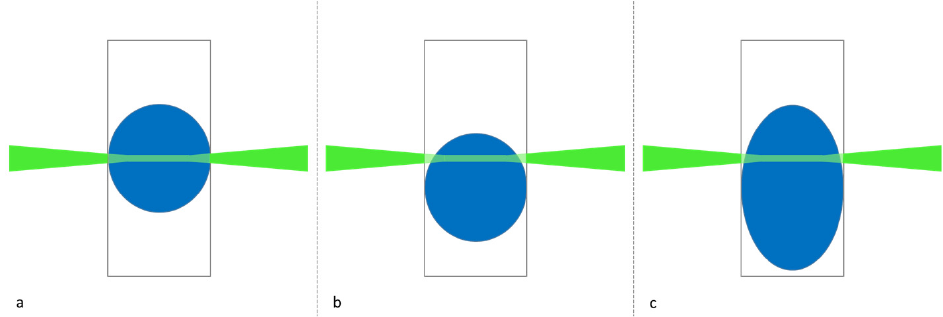
Figure 10. Effect of the positioning of the droplet in the laser. ( a ): The droplet is positioned centrally in the laser, thus the outer phase has no significant effect on the measurement. ( b ): The droplet is not positioned centrally in the laser. As a result, proportionally more outer phase is detected. ( c ): During the measurement, the droplet becomes larger, which means that less outer water phase is